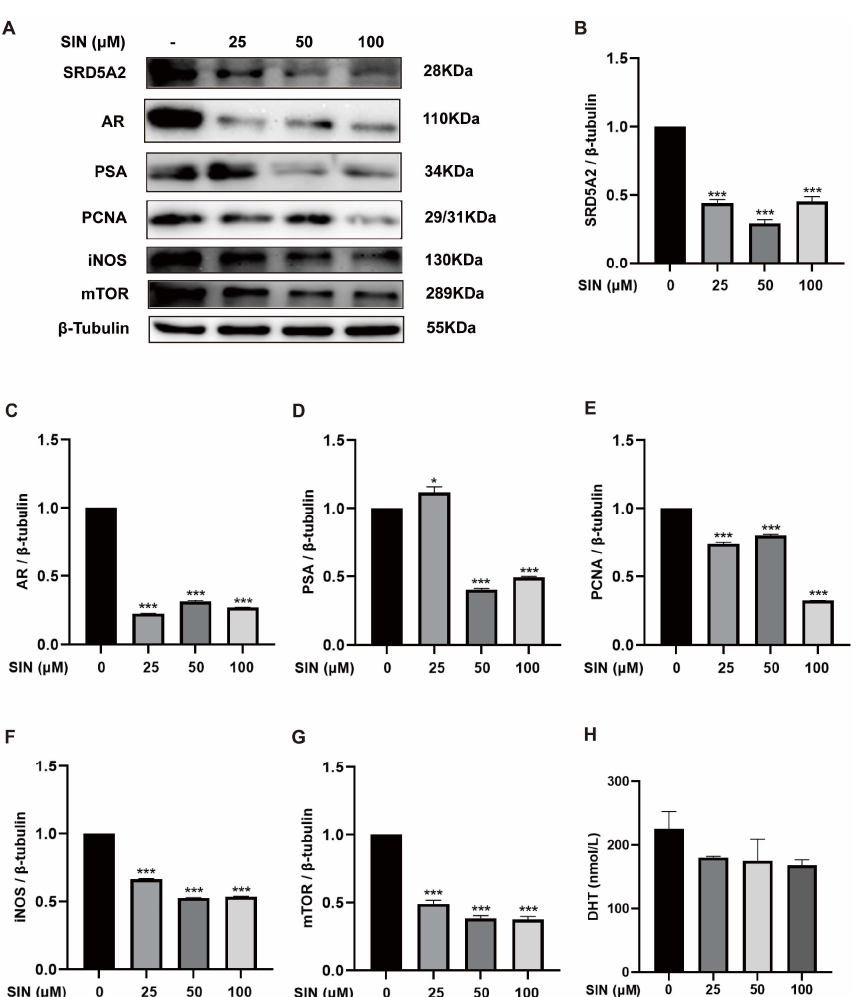
Figure 2. Effect of SIN administration on the AR signaling pathway in BPH-1 cells. ( A ) Effects of SIN treatment on expression of AR signaling pathway-related proteins. Protein quantification for ( B ) SRD5A2, ( C ) AR, ( D ) PSA, ( E ) PCNA, ( F ) iNOS, and ( G ) mTOR versus β -tubulin. ( H ) DHT level in cell supernatants. Data are the mean ± SEM. * p < 0.05, *** p < 0.001 versus the control group. SIN,